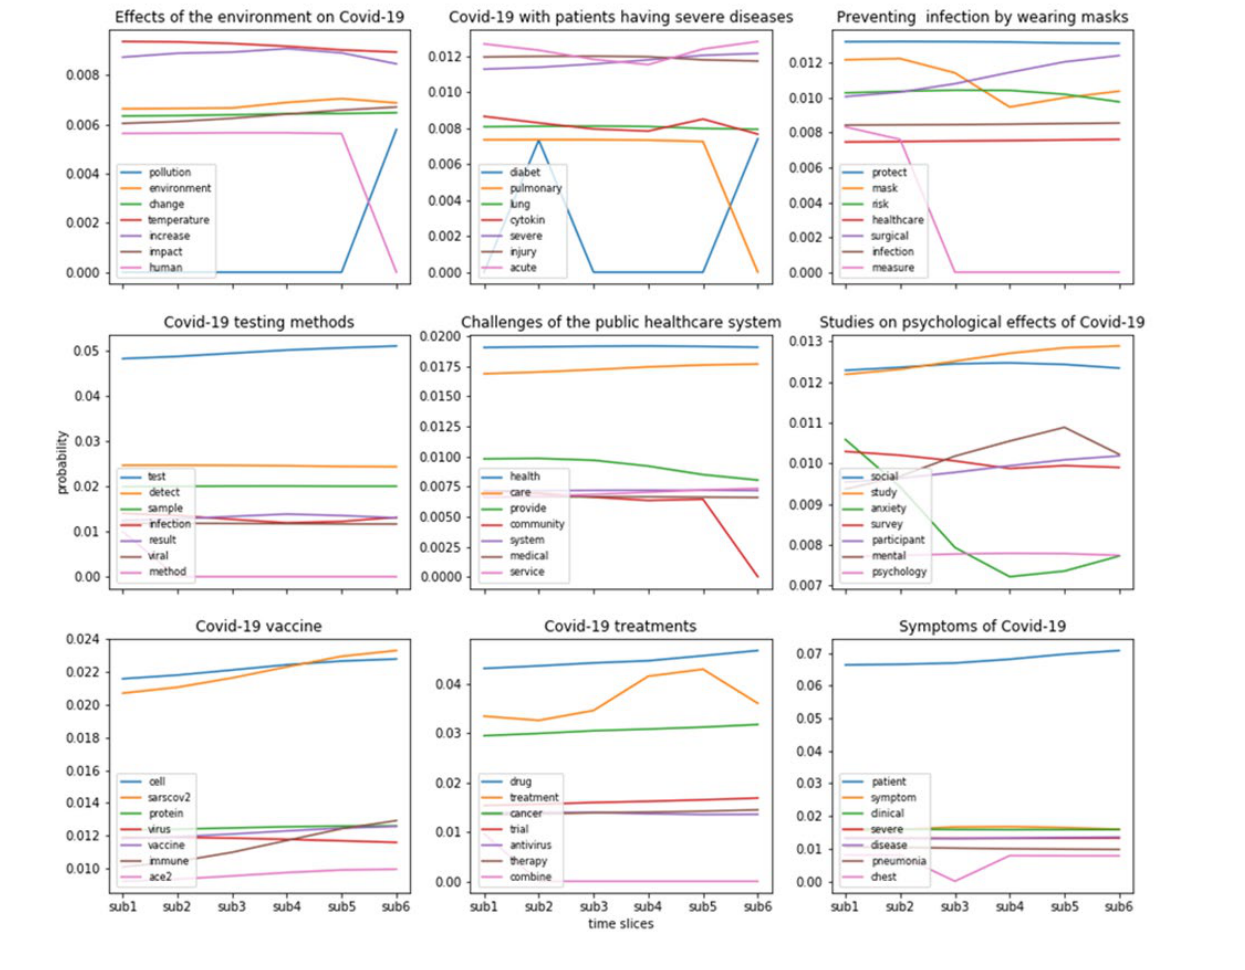
Figure 2 Nine of the most typical topics evolving over six time